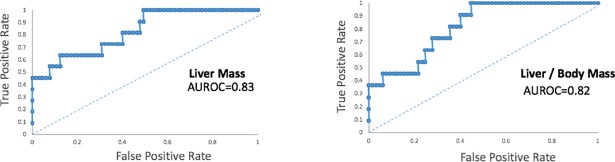
ROC curves for liver mass and liver-to-body mass.ROC curves showing the performance of liver mass as a diagnostic for HCC (AUROC 0.83) and liver-to-body mass ratio for HCC (AUROC 0.83). Data from the entire training set of 76 animals were used for plotting these curves.